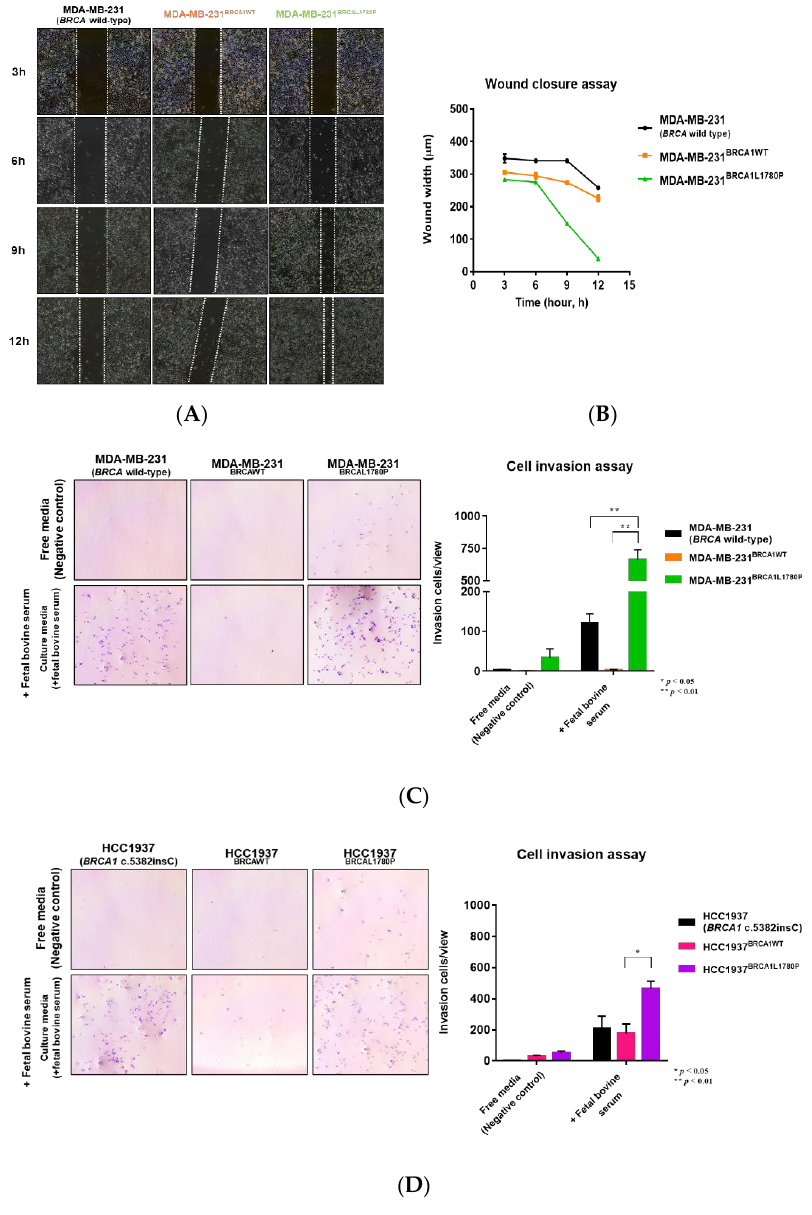
Figure 3. Cell migration of TNBC cell lines stably expressing BRCA1. ( A ) Cell migration assay in stable BRCA1-expressing cell lines. ( B ) Calculation of the wound closure area in stable BRCA1-expressing cell lines. Data are reported as the mean ± standard deviation (SD). ( C , D ) Cell invasion assay in stable BRCA1-expressing cell lines. ( C ) MDA-MB-231 parental and stably transfected cells. ( D ) HCC1937 parental and stably transfected cells. Data are reported as the mean ± standard deviation (SD). Statistical analysis was performed using the chi-square test. (* p < 0.05, ** p < 0.01) .